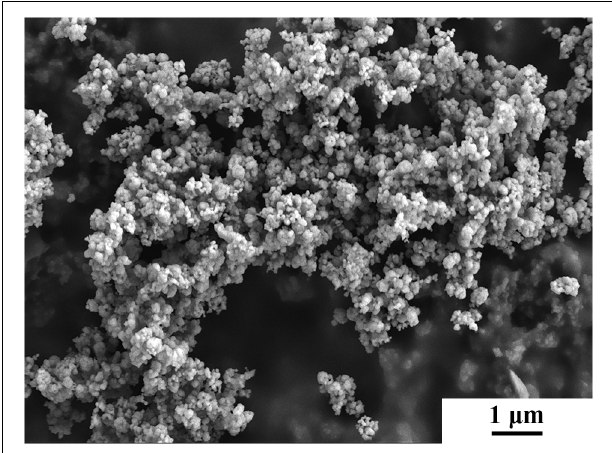
FIGURE 1 | SEM micrograph of ZrO 2 powder.